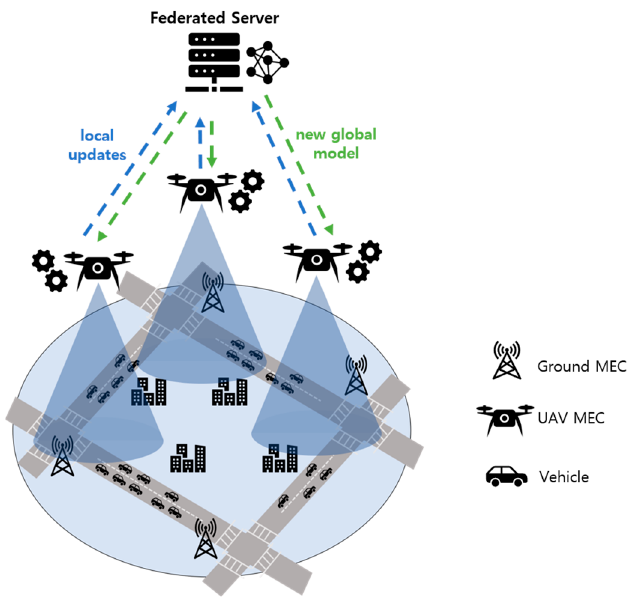
Figure 1. The architecture of the proposed UAV MEC